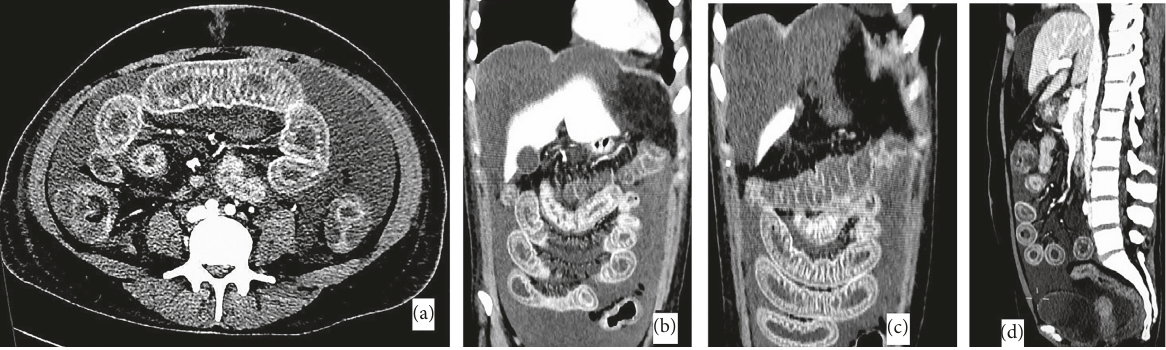
Figure 4: Markedly thickened edematous bowel loops at different segments of GI tract with extensive mucosal enlargement. Patent abdominopelvic vessels with no evidence of ischemia. (a) Axial view, (b)-(c) coronal view, and (d) sagittal view. Table 2: Autoimmune workup.